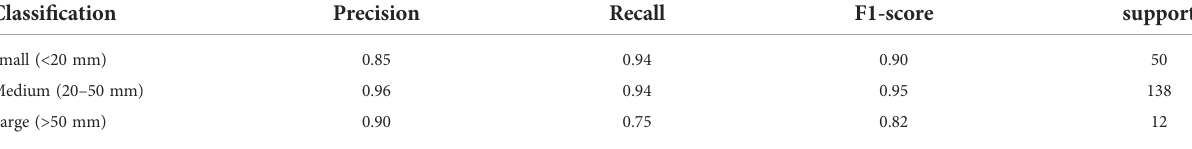
TABLE 4 Final predicted metrics of the classi fi cation.